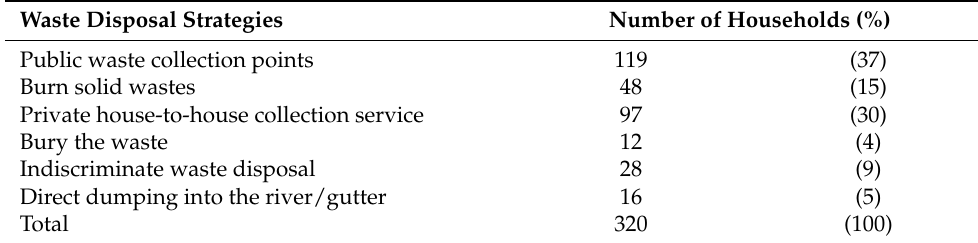
Table 2. Solid waste disposal options named by household.